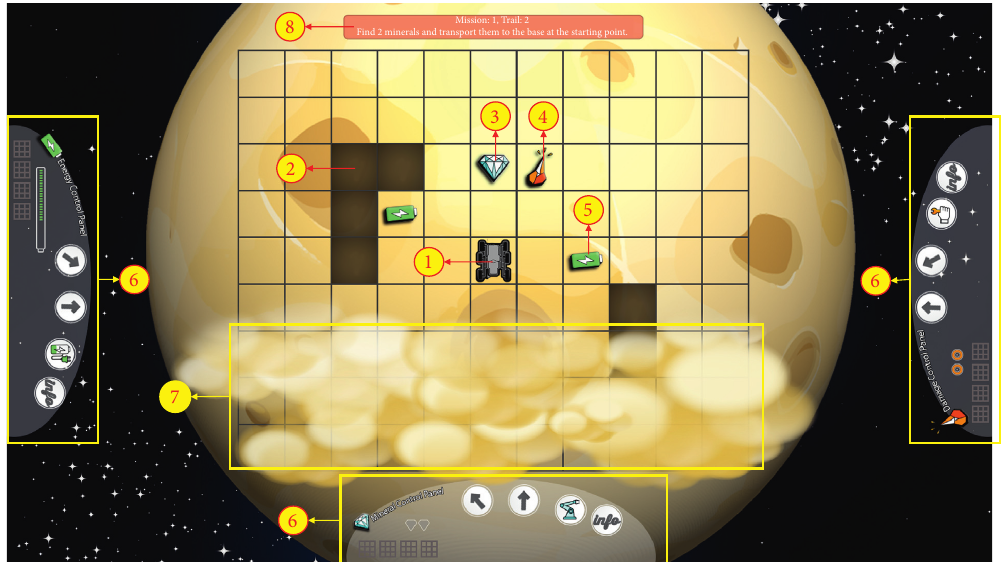
Figure 2: Overview of the activity (Mission 1): (1) the rover located in the station cell; (2) the canyons (to be avoided, cause mission failure); (3) the collectable mineral; (4) the rock (to be avoided, causing damage to the rover); (5) the battery (collectable) item; (6) the personal control panels; (7) the area affected by the dust storm (items located in this part of the grid are hidden); (8) the task description for the current